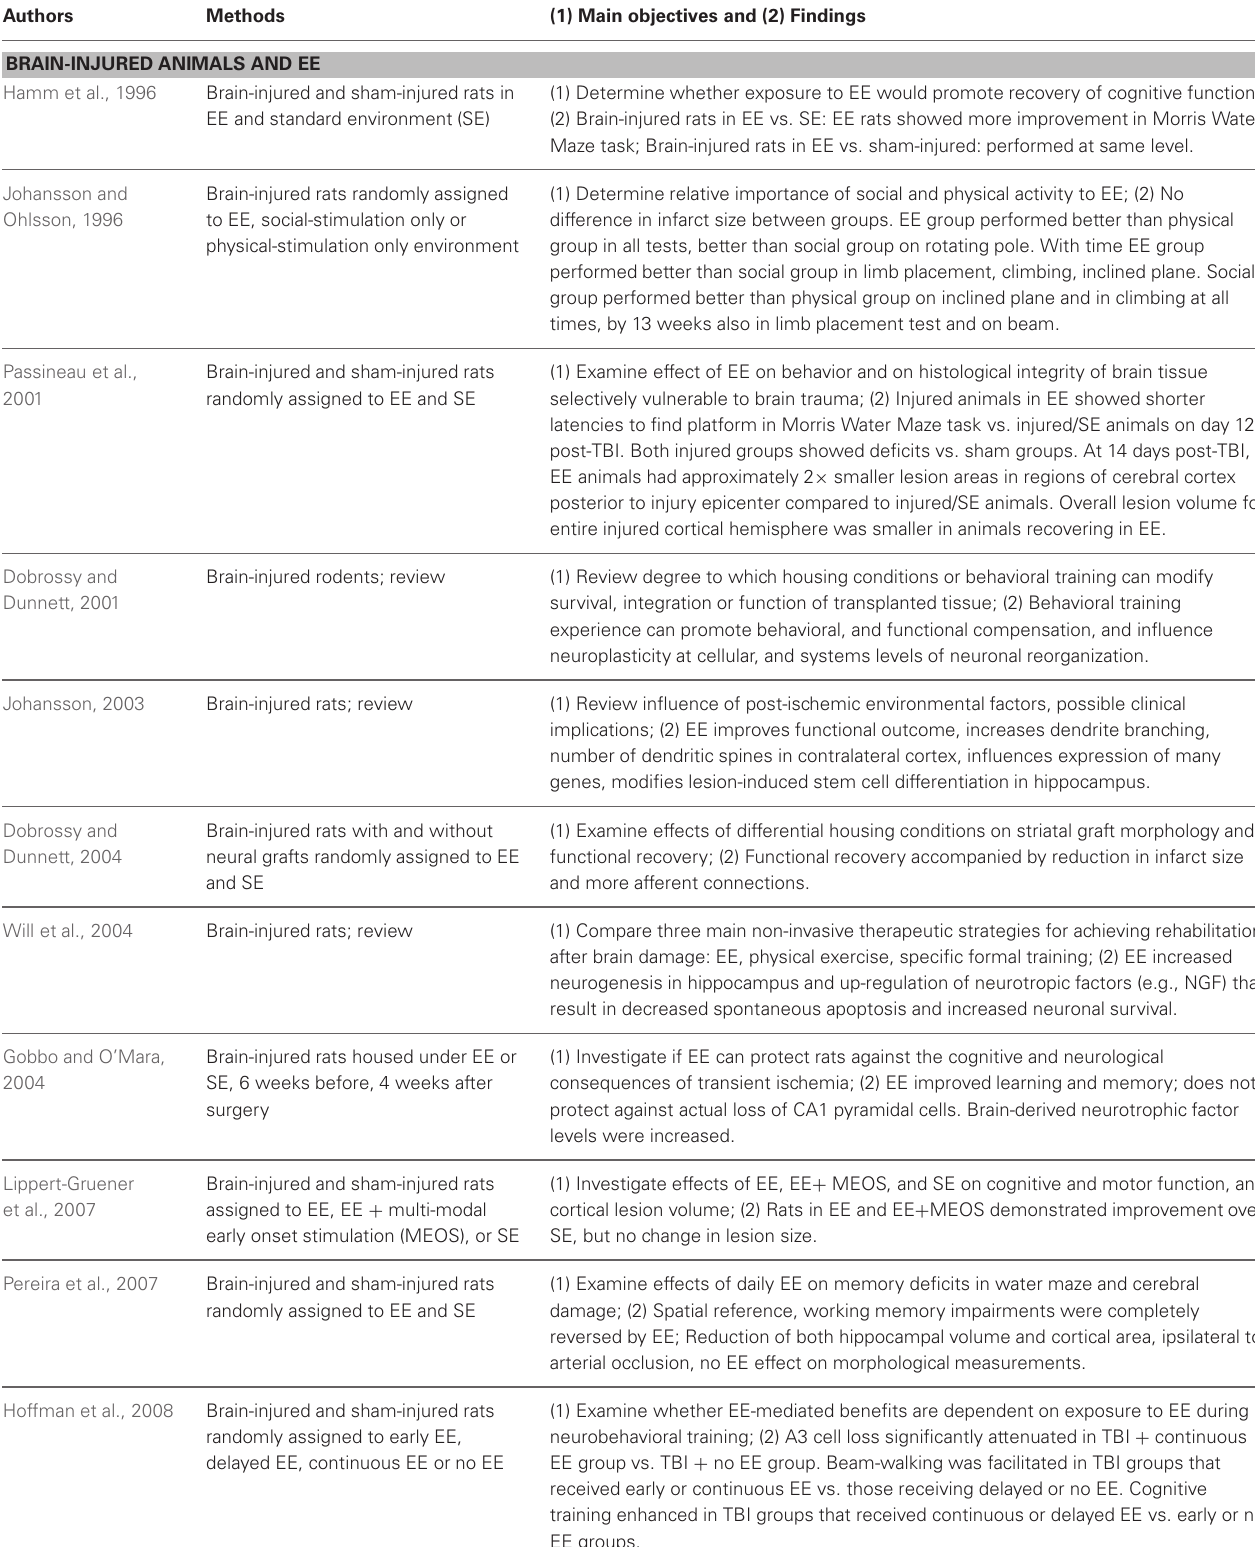
Table 2 | Detailed summary of articles included in “Brain-injured animals and EE” and “Brain-injured humans and EE” scoping review.